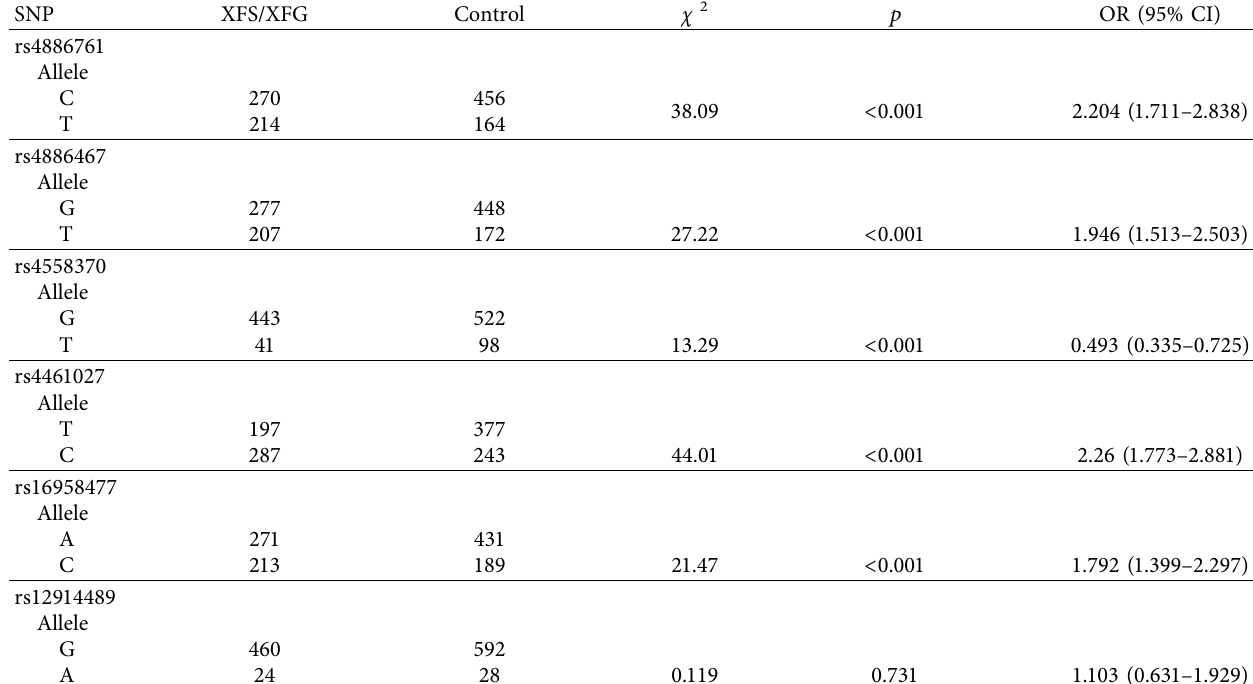
Table 4: Associations of various alleles with the